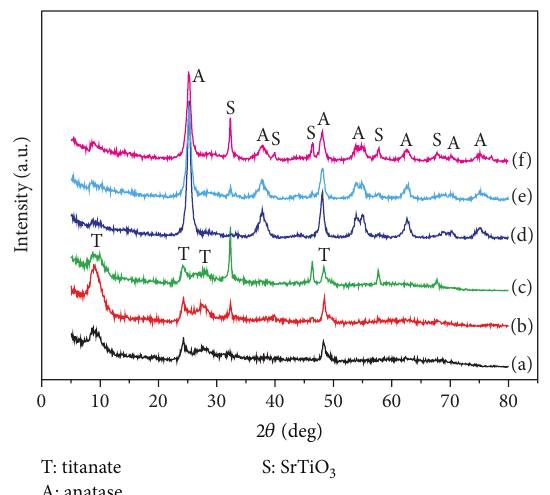
Figure 1: XRD patterns for the uncalcined ((a): 1%; (b): 2%; (c): 5%) and calcined ((d): 1%; (e): 2%; (f): 5%) samples with different Sr/Ti